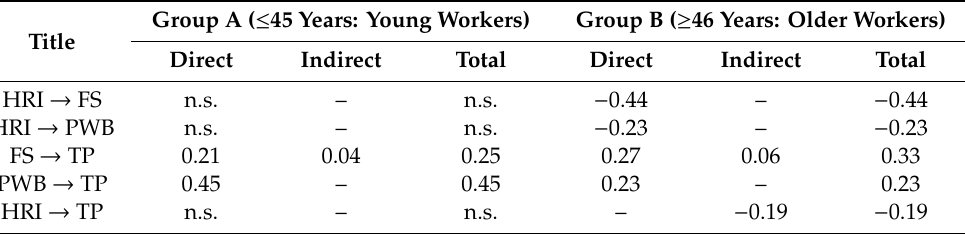
Table 9. Direct, indirect, and total e ff ects of path coe ffi